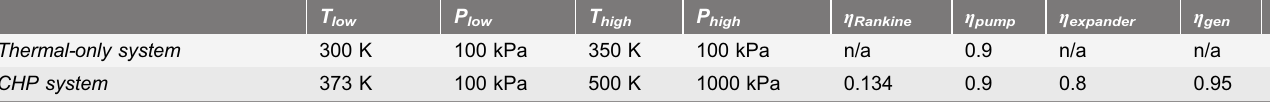
Table 1. Rankine cycle performance constants for solar